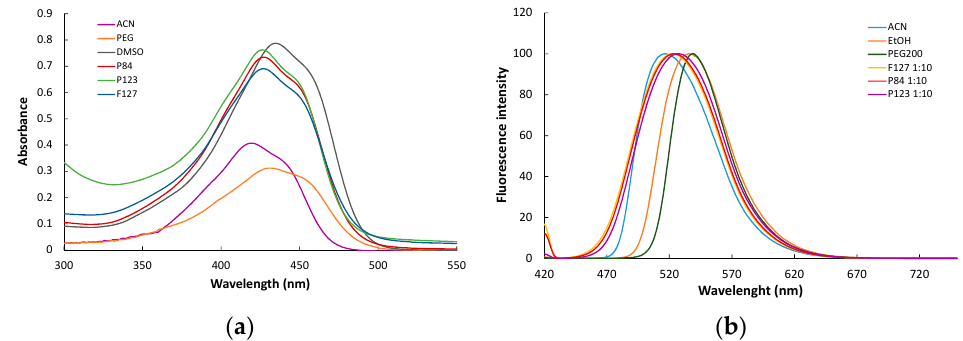
Figure 5. UV-VIS ( a ) and fluorescence ( b ) spectra of CURC encapsulated in various micellar systems and dissolved in various solvents.